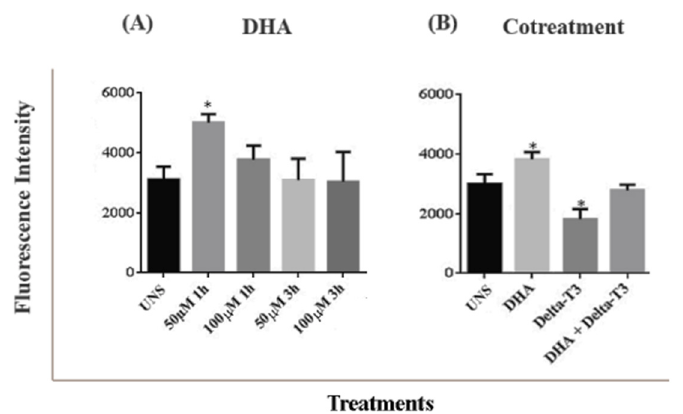
Figure 3. ( A ) Reactive oxygen species (ROS) generation in MDA-MB-231 cells treated with DHA for 1 or 3 h (50 μ M and 100 μ M). ( B ) ROS generation in MDA-MB-231 cells treated with DHA (50 μ M), Delta-T3 (5 μ M) and co-treatment for 1 h. ROS generation was assessed by cell ROX deep red